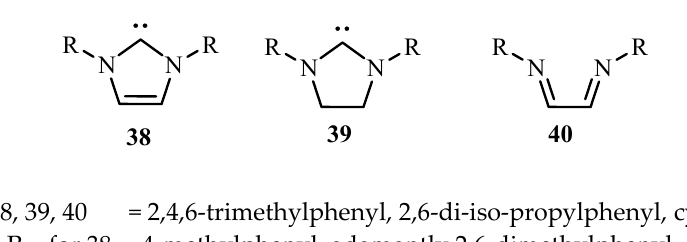
Figure 6. N-heterocyclic carbene (NHC) ligands of diazabutadienes reviewed by Hillier et al. [17].